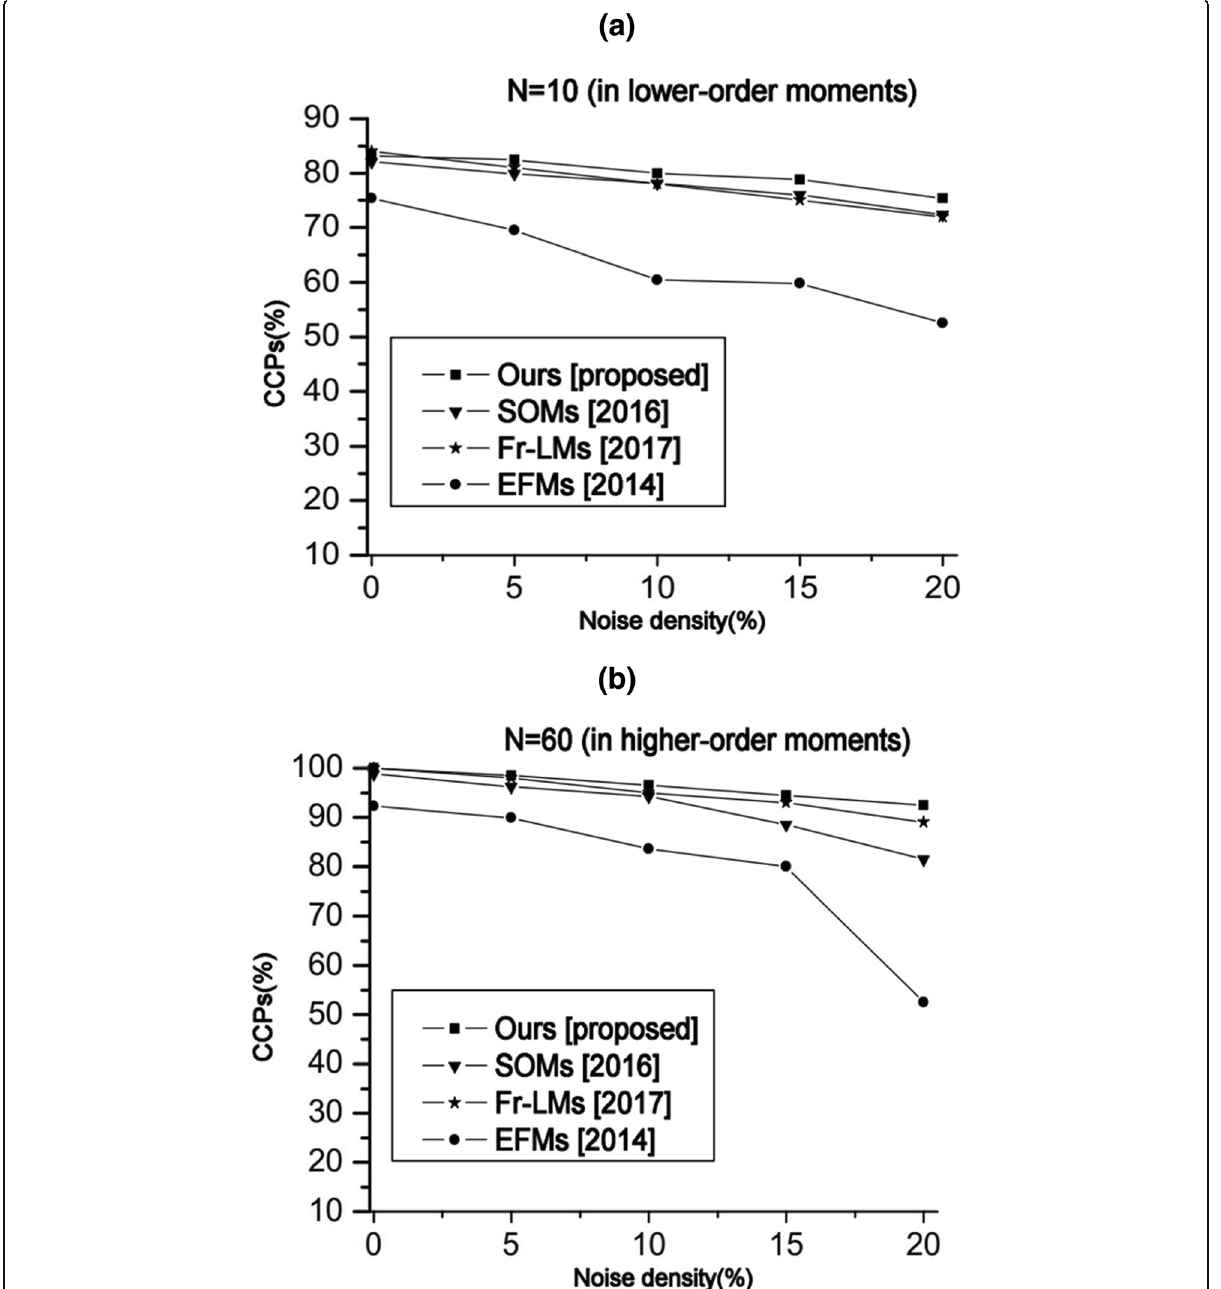
Fig. 20 Comparative analysis of CCPs under different noise densities in experiment 3. a In lower-order moments. b In higher-order